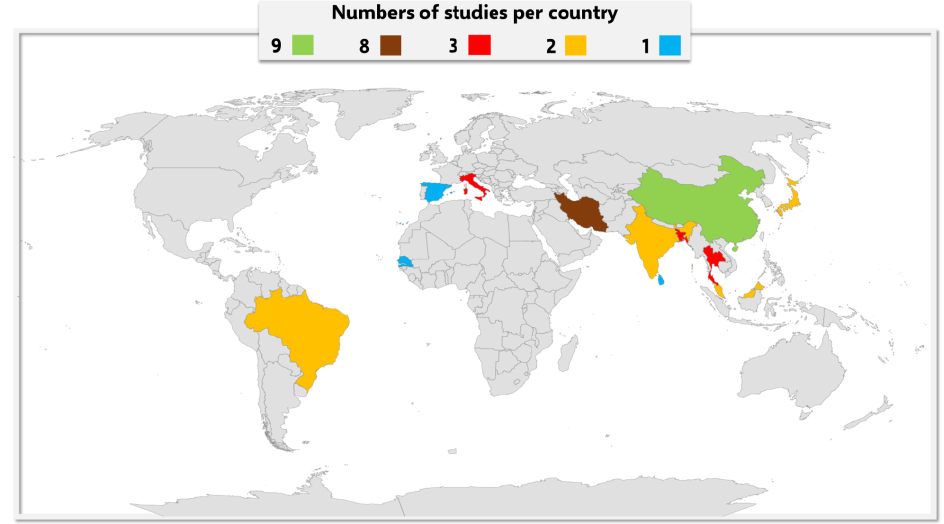
Figure 2. Distribution of scientific production on the applications of LCA in the rice sector.